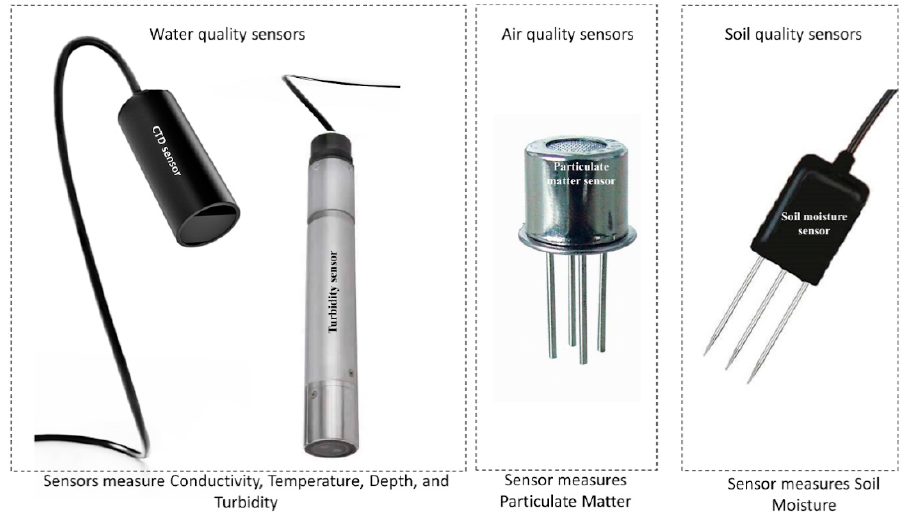
Figure 3. Schematic diagram of environmental sensors for IoT applications .